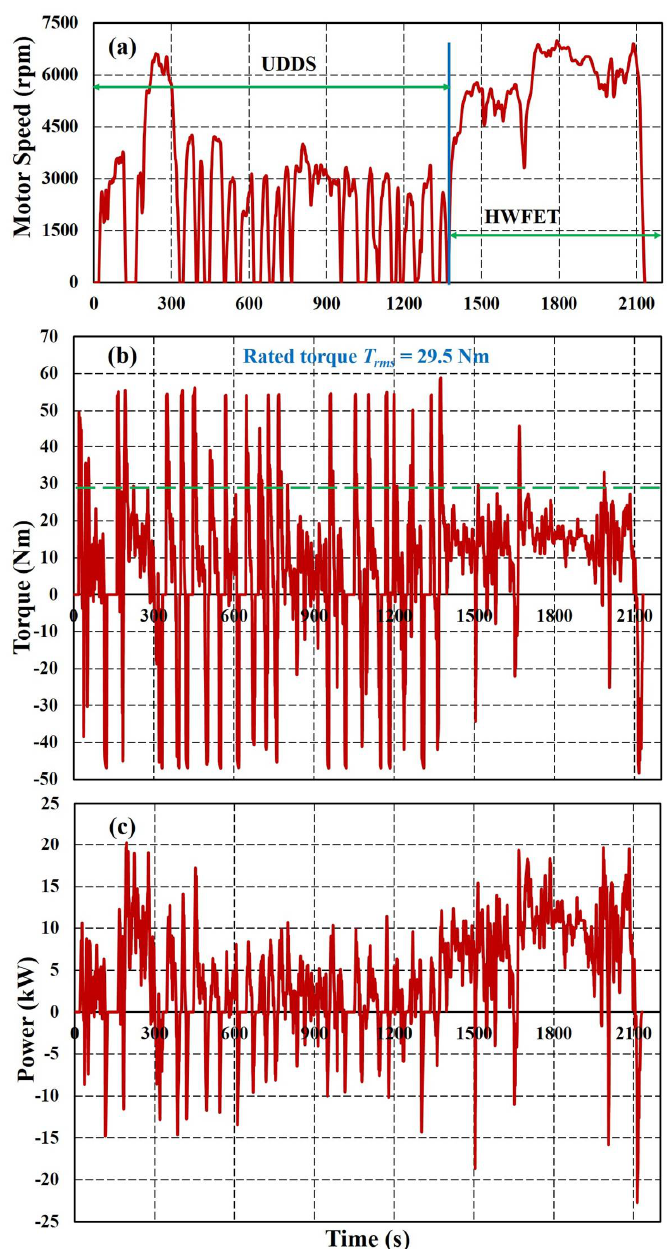
Figure 13. Motor ( a ) speed; ( b ) torque; and, ( c ) power over the driving cycles.